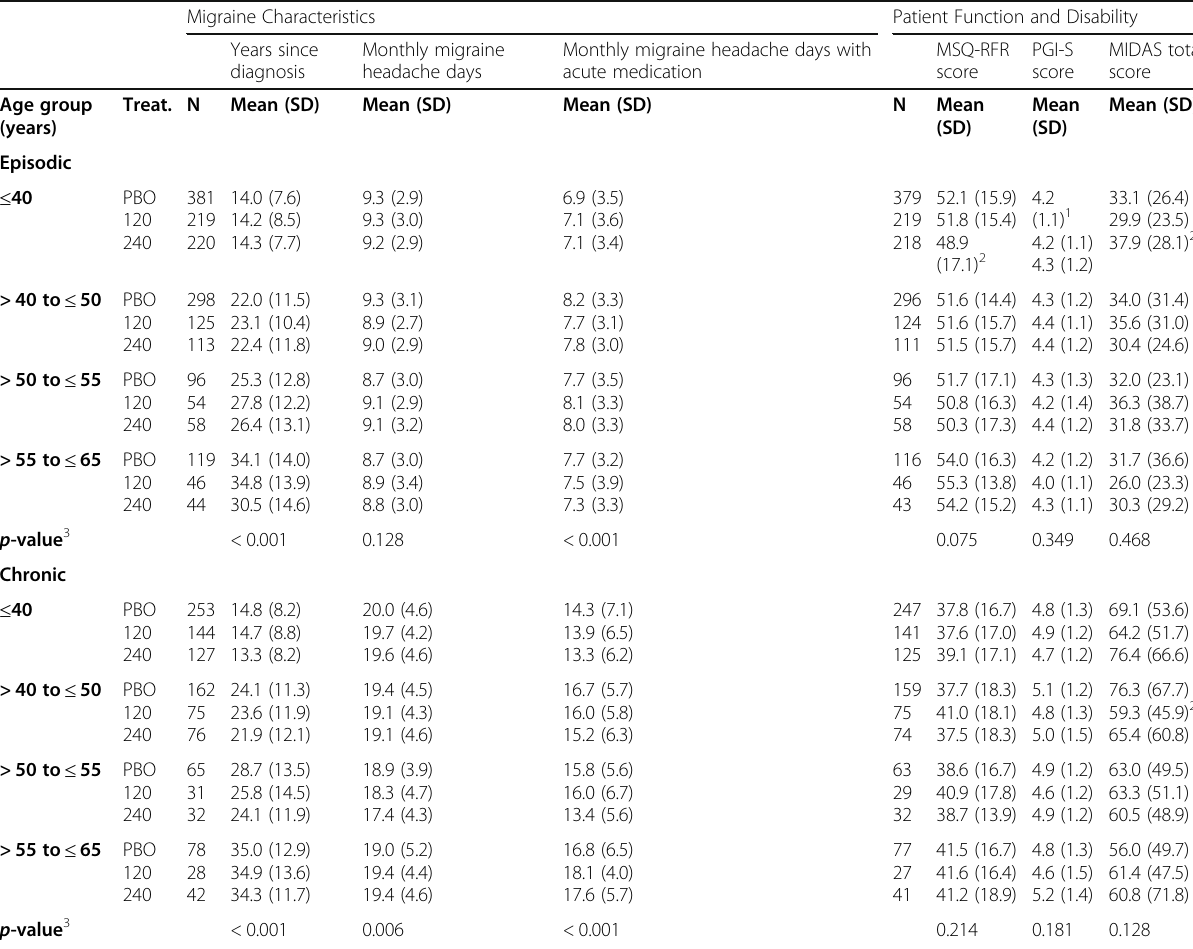
Table 3 Baseline migraine characteristics and patient function and disability for 4 age groups (efficacy groupings) Migraine Characteristics Patient Function and